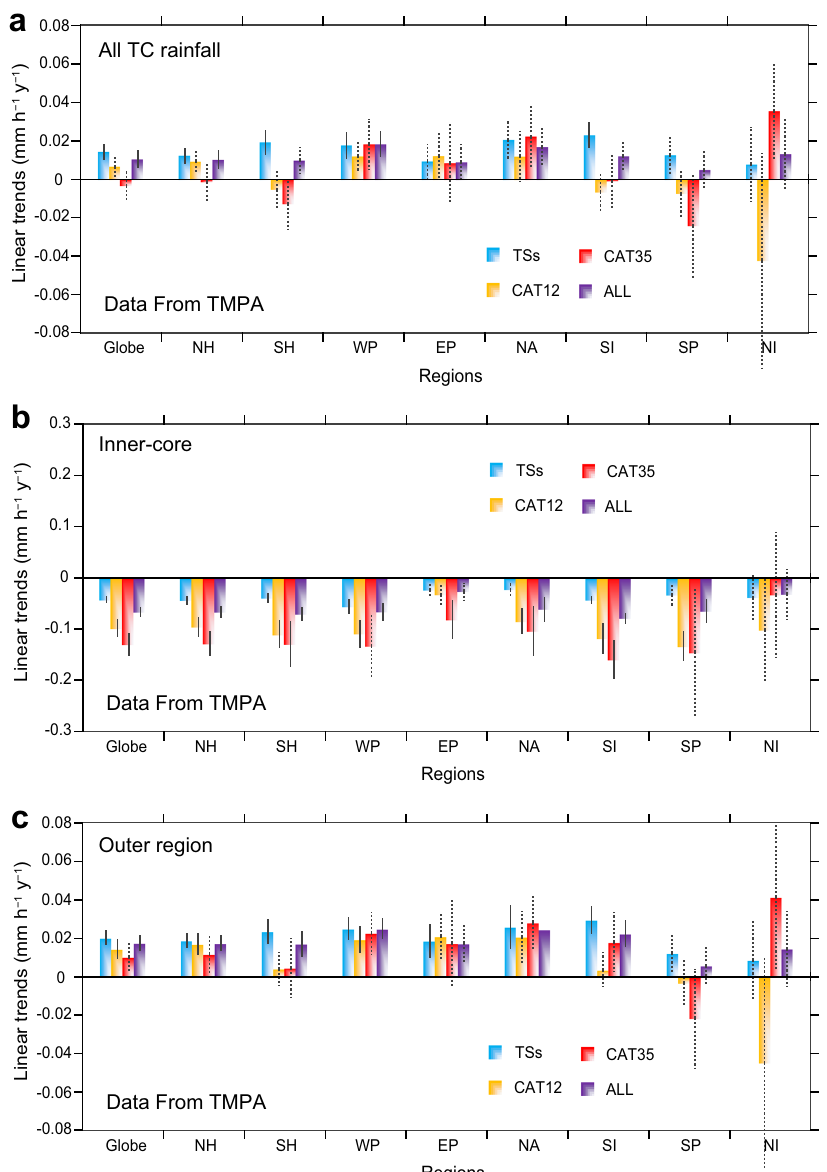
Fig. 2 Linear trends (mm h – 1 y – 1 ) of tropical cyclone (TC) rain rate based on the Tropical Rainfall Measuring Mission (TRMM) Multi-Satellite Precipitation Analysis (TMPA) dataset in various ocean basins. a All TC rainfall, b Inner-core of TC, c Outer region of TC. Globe: Globally-averaged, NH: North Hemisphere, SH: South Hemisphere, WP: Western North Paci fi c, EP: Eastern North Paci fi c, NA: North Atlantic, SI: South Indian Ocean, SP: South Paci fi c, NI: North Indian Ocean. The colors are for different TC intensity categories; tropical storms (blue), category 1 – 2 (orange), category 3 – 5 (red), and all three types of TCs (purple). The vertical lines indicate the standard error of the linear trends (solid signi fi cant at 95%, and dashed insigni fi